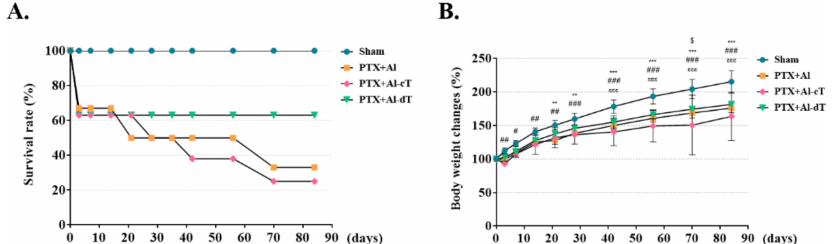
Figure 5. Measurement of survival rates and body weight changes. The in vivo therapeutic effi- cacy of alginate microbeads was confirmed using the PTX animal model. ( A ) Survival rates and ( B ) body weight changes were measured at various time points during the experiment. Statistically significant differences between Sham and PTX+Al are denoted as ** p < 0.01 and *** p < 0.001; statis- tically significant differences between Sham and PTX+Al-cT are denoted as # p < 0.05, ## p < 0.01, and ### p < 0.001; statistically significant difference between Sham and PTX+Al-dT is denoted as εεε p < 0.001; statistically significant difference between PTX+Al-cT and PTX+Al-dT is denoted as $ p <